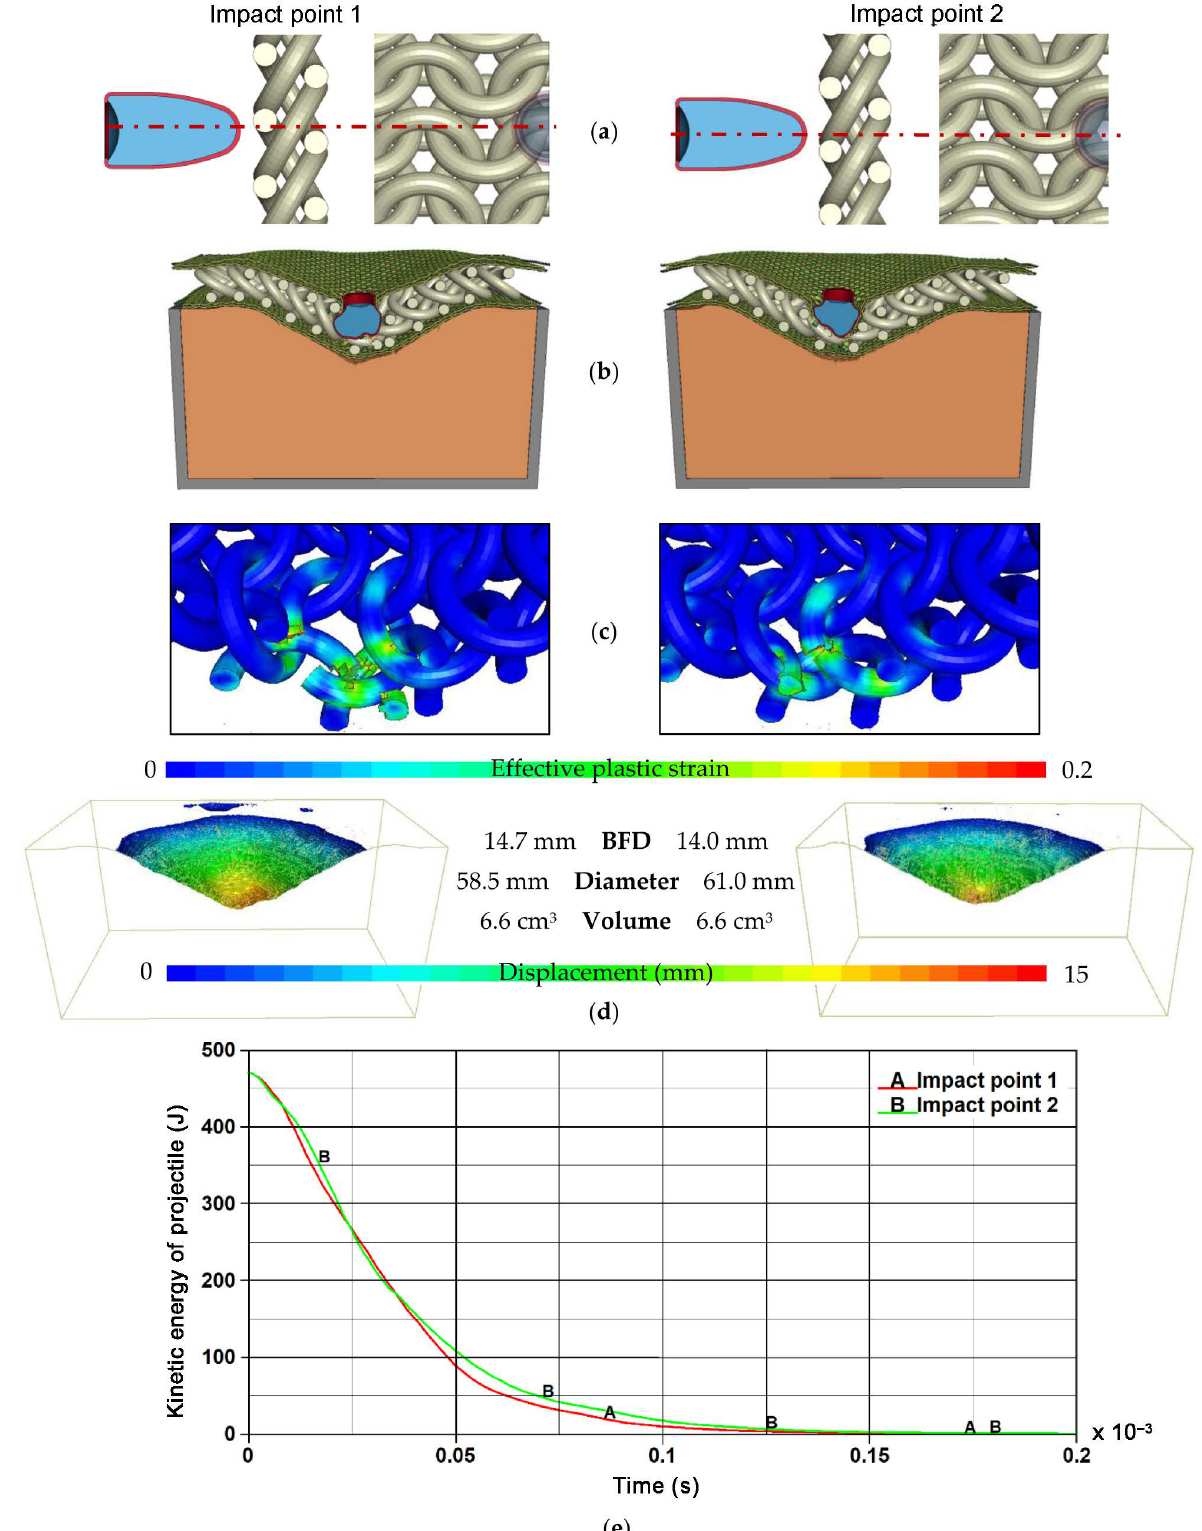
Figure 14. Results of simulation for S2 structure: ( a ) location of the impact point; ( b ) final deformation; ( c ) distribution of effective plastic strain in the titanium structure; ( d ) shape of the hollow in the ballistic clay and ( e ) plot of the projectile energy against time.